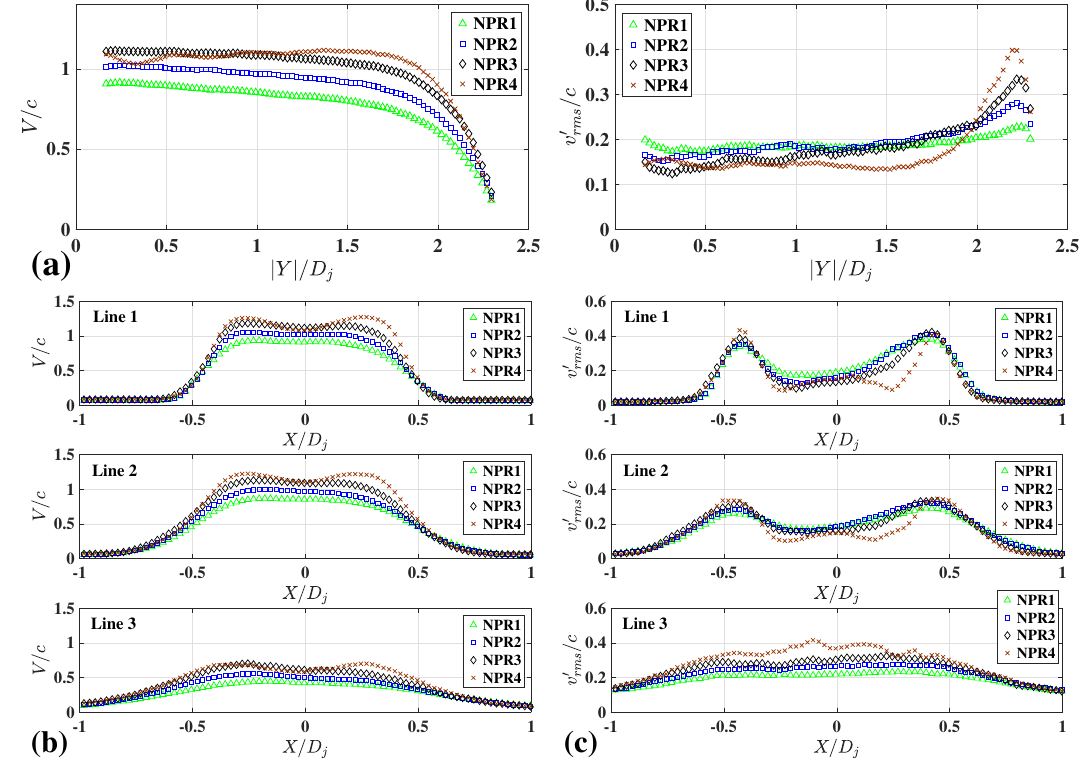
Figure 7. Comparisons of statistical results obtained from PIV measurements of under-expanded impinging jets with e = 30 mm ( e / D j = 2.46) for various values of NPRs, i.e., NPR 1 = 2, NPR 2 = 2.2, NPR 3 = 2.5, and NPR 4 = 2.77. ( a ) Normalized mean axial velocity V / c and normalized RMS fluctuating axial velocity v (cid:48) rms / c along the jet centerline ( x = 0); ( b , c ) showed normalized statistical profiles of V / c and v (cid:48) rms / c , respectively, obtained along Line 1 ( y = − 2.54) mm, Line 2 ( y = − 12.7) mm, and Line 3 ( y = − 27.46)